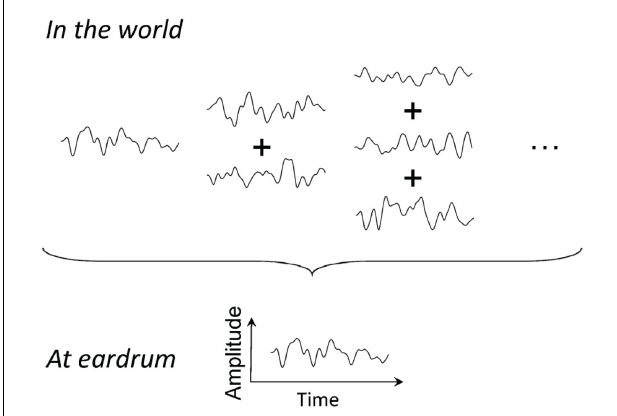
FIGURE 2 | Scene analysis as an ill-posed problem. All the pressure waves from different sound sources combine linearly in the air. As a result, any waveform observed at the ears may have been caused by one, two, or in fact an unknown number of sound sources. Determining the number and nature of sound sources from the compound waveform is an ill-posed problem.